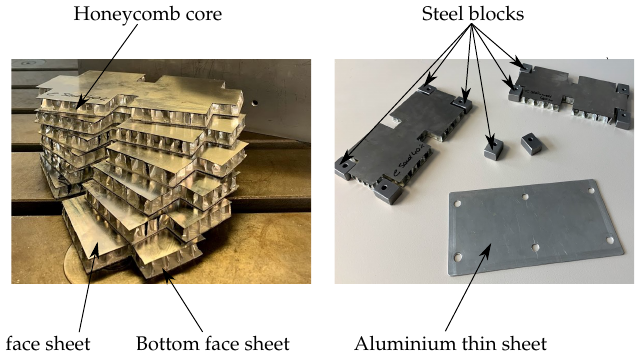
Figure 2. Left: Honeycomb damping plates (HCDP) filled with granular materials. Right: Steel blocks and thin aluminium sheet used for attaching HCDP to the WTS test specimen.